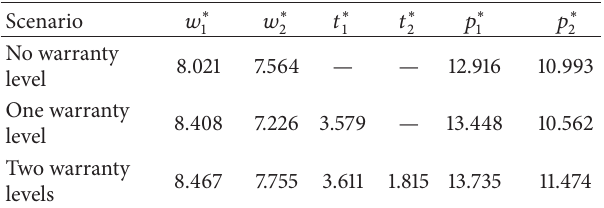
Table 5: Comparison of the optimal decisions with and without warranty